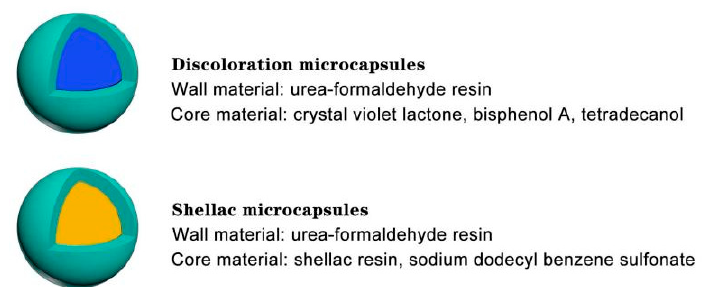
Figure 1. Two kinds of sphere microcapsules with a core and surface shell.